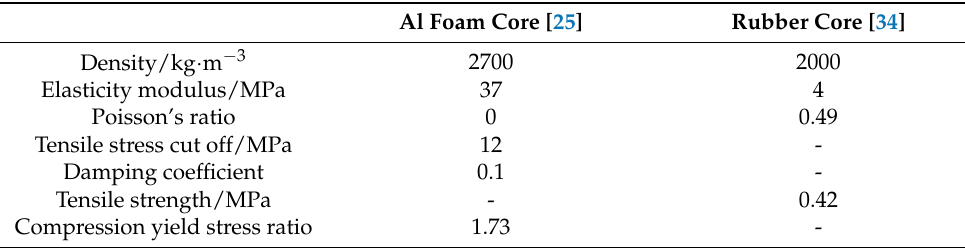
Table 3. Material parameters of the rubber and Al foam core.